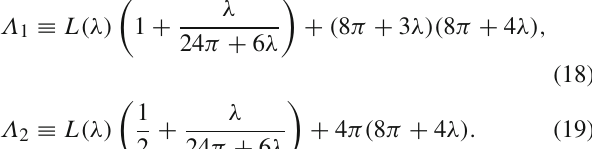
Fig. 2 Evolution of the matter-energy density of the universe in red- shift for λ = 0 . 857. The thin (blue) line stands for the usual PF while the dotted (green) line represents the SMF. Effectively, the universe behaves as composed of one fluid, whose density is given by the sum of those contributions, as in the thick (red) curve